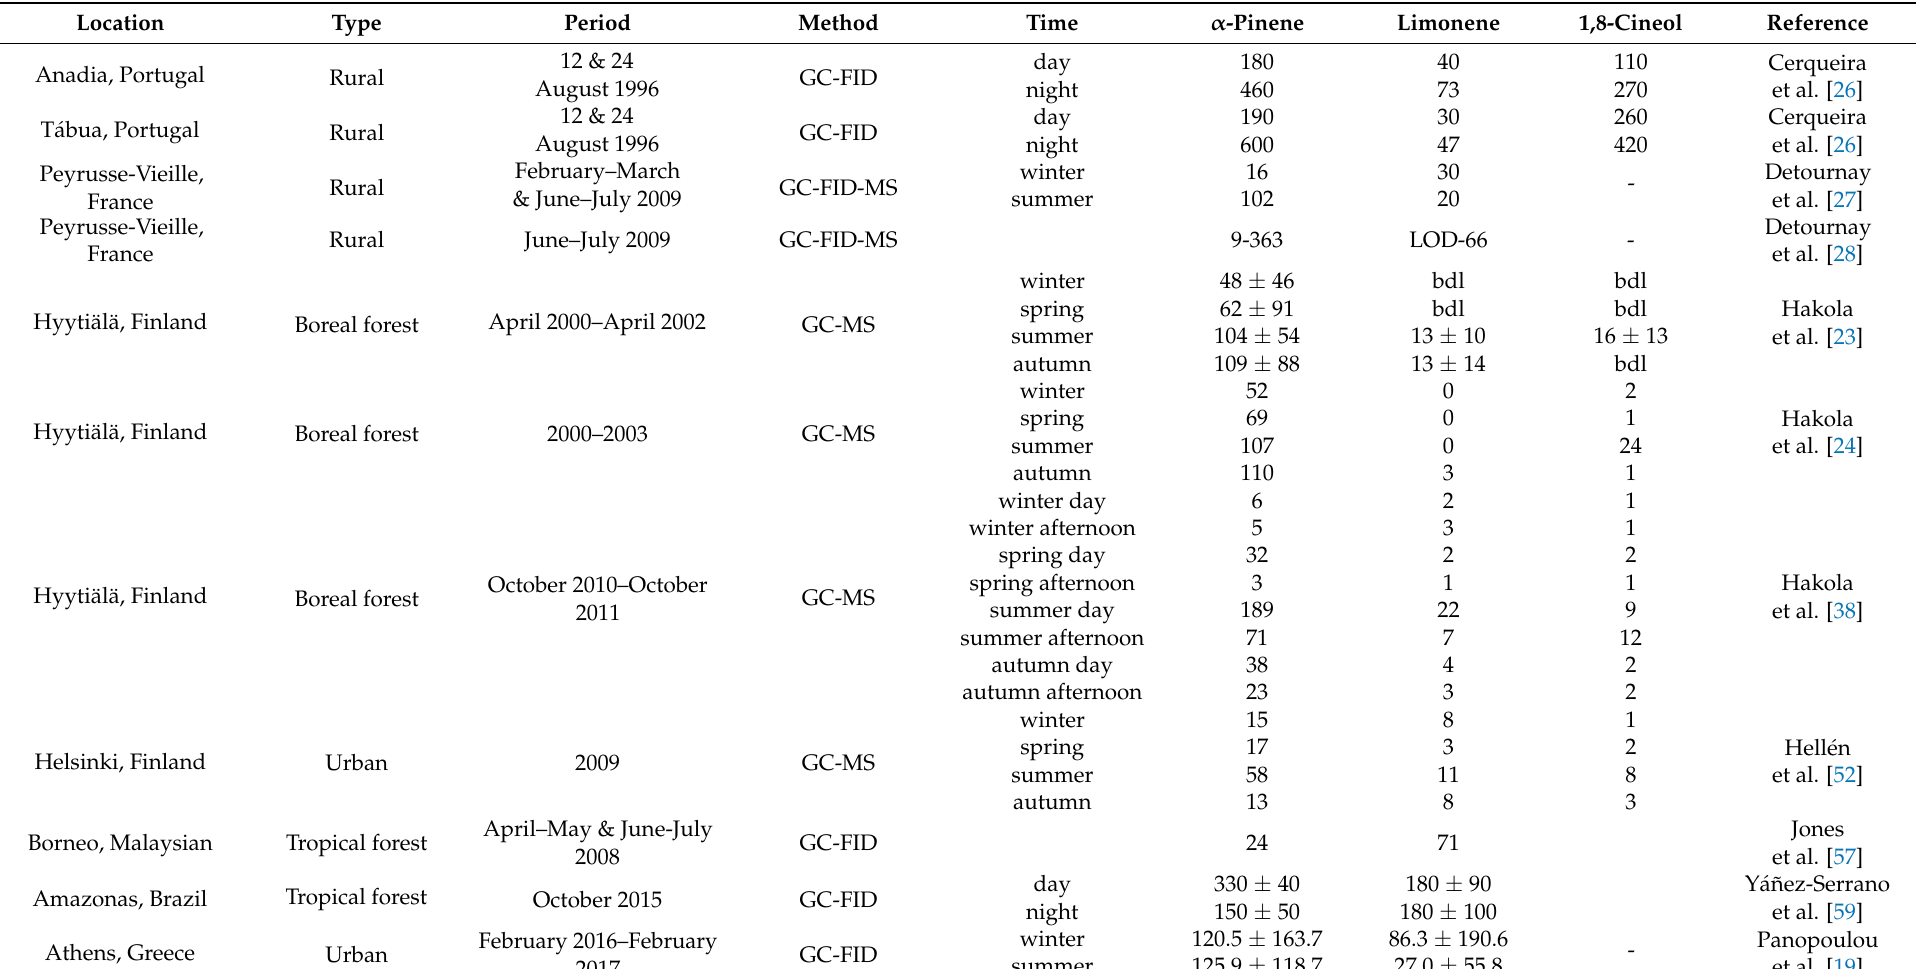
Table 2. Comparison of this work with those reported in the literature: α -pinene, limonene and 1,8-cineol observations in different environments (with standard deviation when available) (mixing ratios in ppt). bdl: below detection